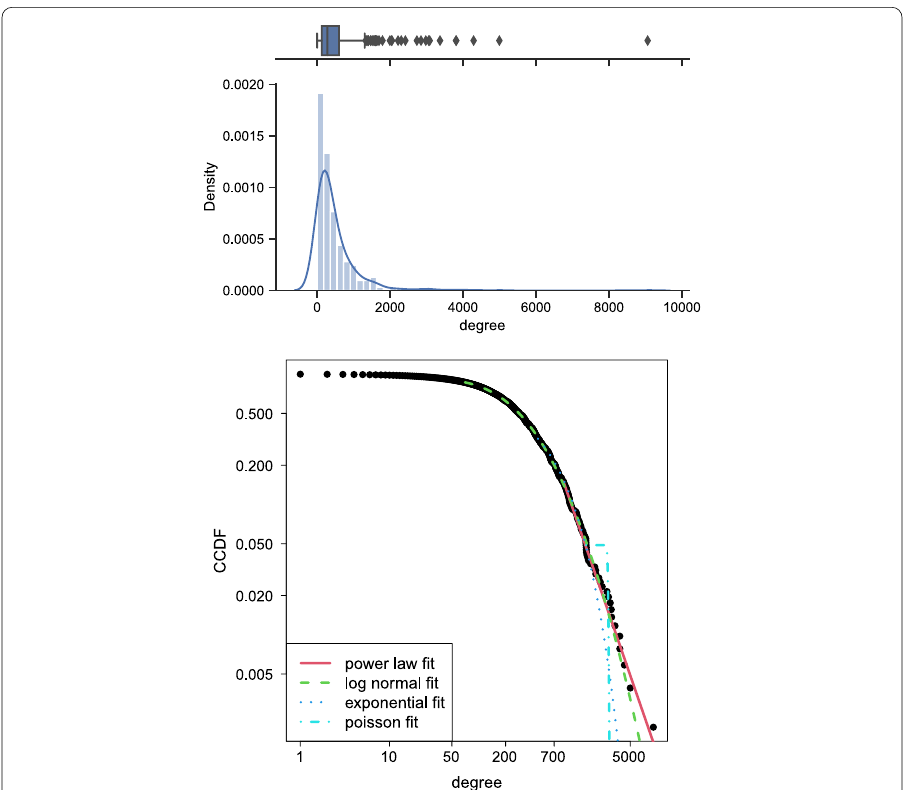
Fig. 9 I nstancEs full-degree distribution: boxplot and Probability Density Function (top), and Complementary Cumulative Distribution Function, with various distribution fittings